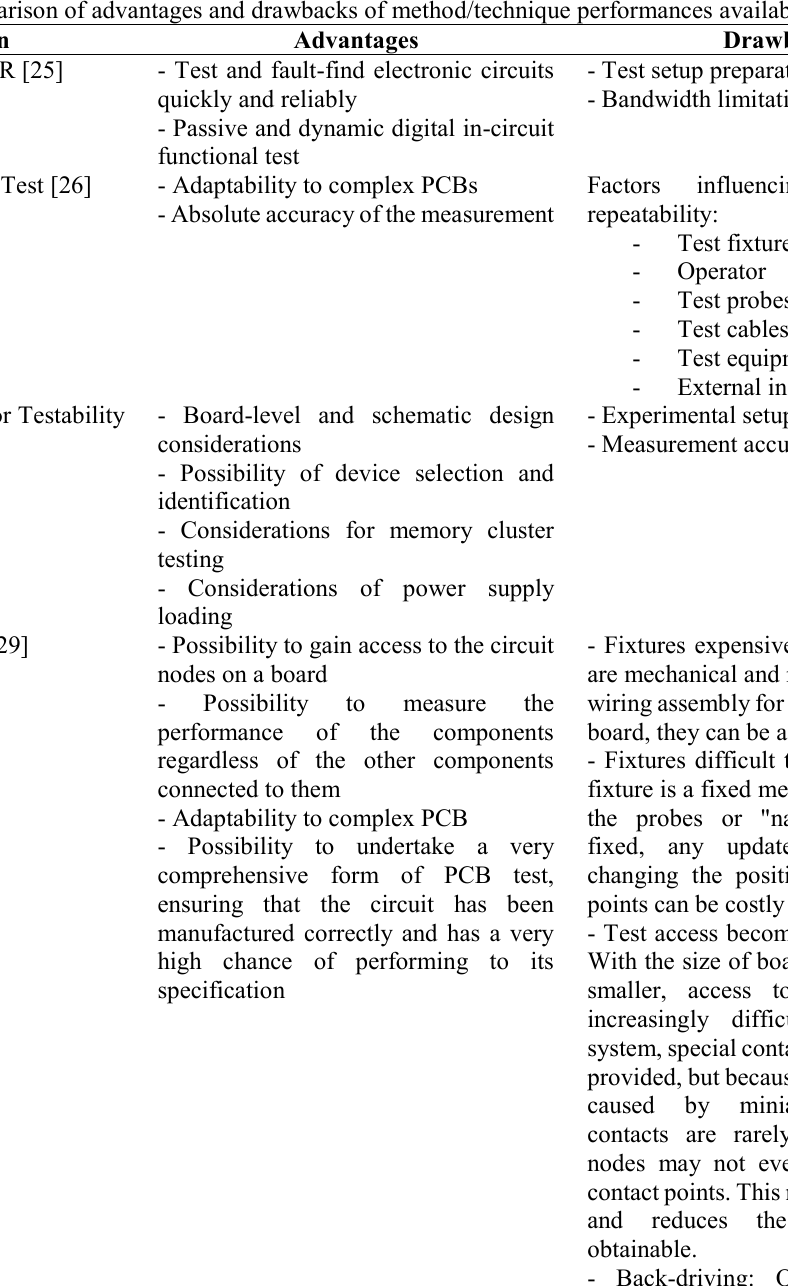
Table 4: Comparison of advantages and drawbacks of method/technique performances available in the